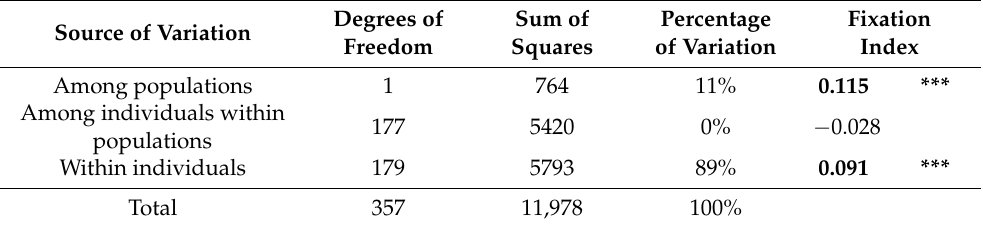
Figure 2. Results of the STRUCTURE analysis for K = 2–5. The gray color bars indicate region numbers (1, North of Soso; 2, South of Soso and Iwaki; 3, Ken-Poku; 4, Ken-Chu; 5, Ken-Nan; 6, Aizu). Location of each region has provided in Figure 1B. Table 1. Analysis of molecular variance (AMOVA) of two populations of wild boars divided to east and west side between Abukuma River in Fukushima